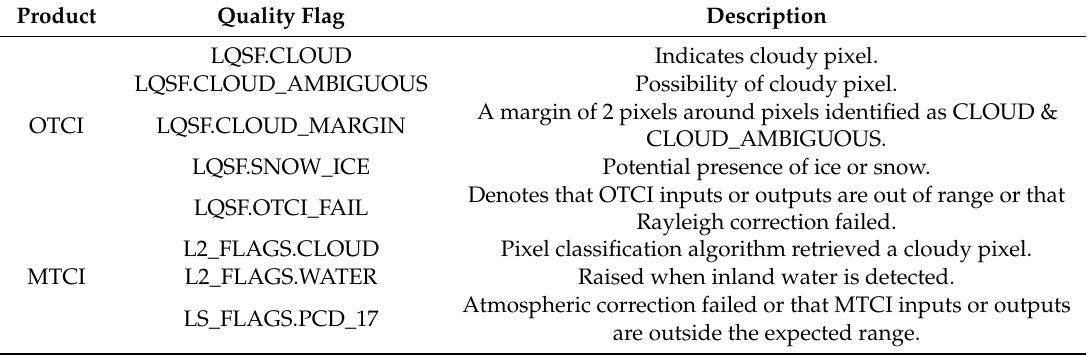
Table 3. Quality flags applied to exclude unreliable pixels used in the generation of the Envisat